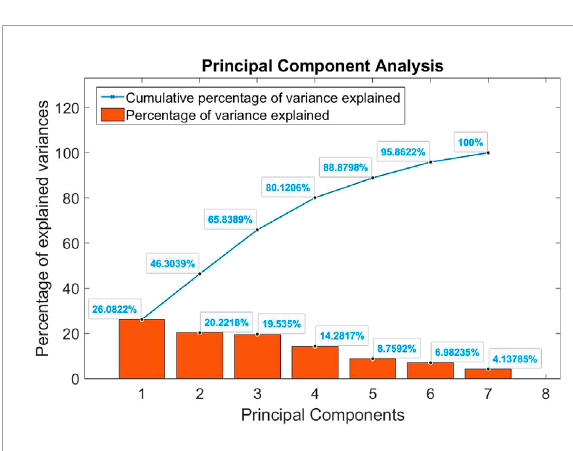
FIGURE 11 Percentage of explained variance for each principal component from the principal component analysis (in red bins) of the 7 parameters ( | B | , X, Y and Z-components of the IMF, solar wind speed, density and temperature) and the cumulative percentage value in